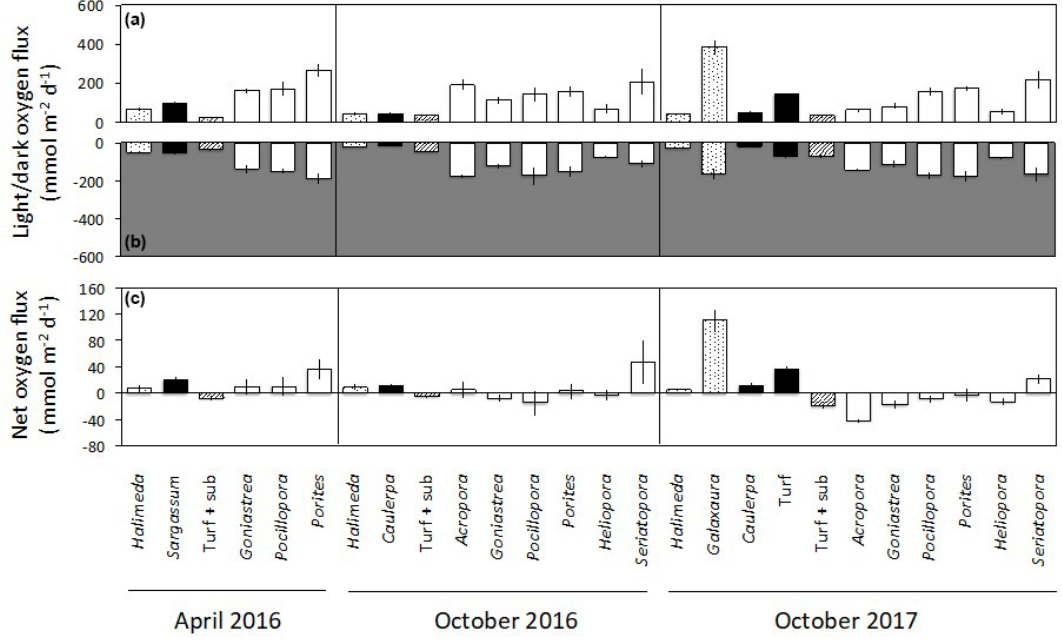
Figure 3. Net changes in oxygen (mean ± SE) in light (a) and dark (b) incubations of calcifying algae (stippled), macroalgae and turf (black), turf + substrate (diagonal stripes) and coral (white) standardised by specimen surface area. Panel (c) shows the net daily production of oxygen (mean ± SE), assuming a 12h photoperiod and stable rates of photosynthesis and dark respiration over a 24h period.